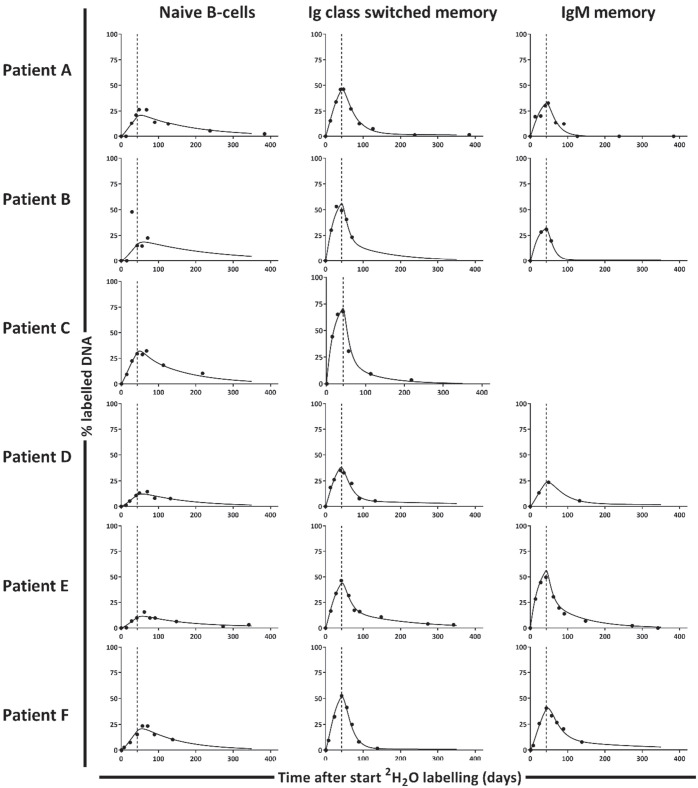
Best fits of 2H enrichment in B-cell subsets in autologous hematopoietic stem cell transplantation (autoHSCT) patients.Best ﬁts of the model (see Materials and methods) to the enrichment data in naive, Ig class-switched memory and IgM+ memory B-cells in the six autoHSCT patients (A–F). Measured enrichments are shown by black dots. Label enrichment in the DNA was scaled between 0% and 100% by normalizing for the maximum enrichment in granulocytes (see Materials and methods). The end of 2H2O administration is marked by a dashed vertical line. Best fits of 2H enrichment of the corresponding subsets in healthy individuals were previously published by Westera et al., 2015.